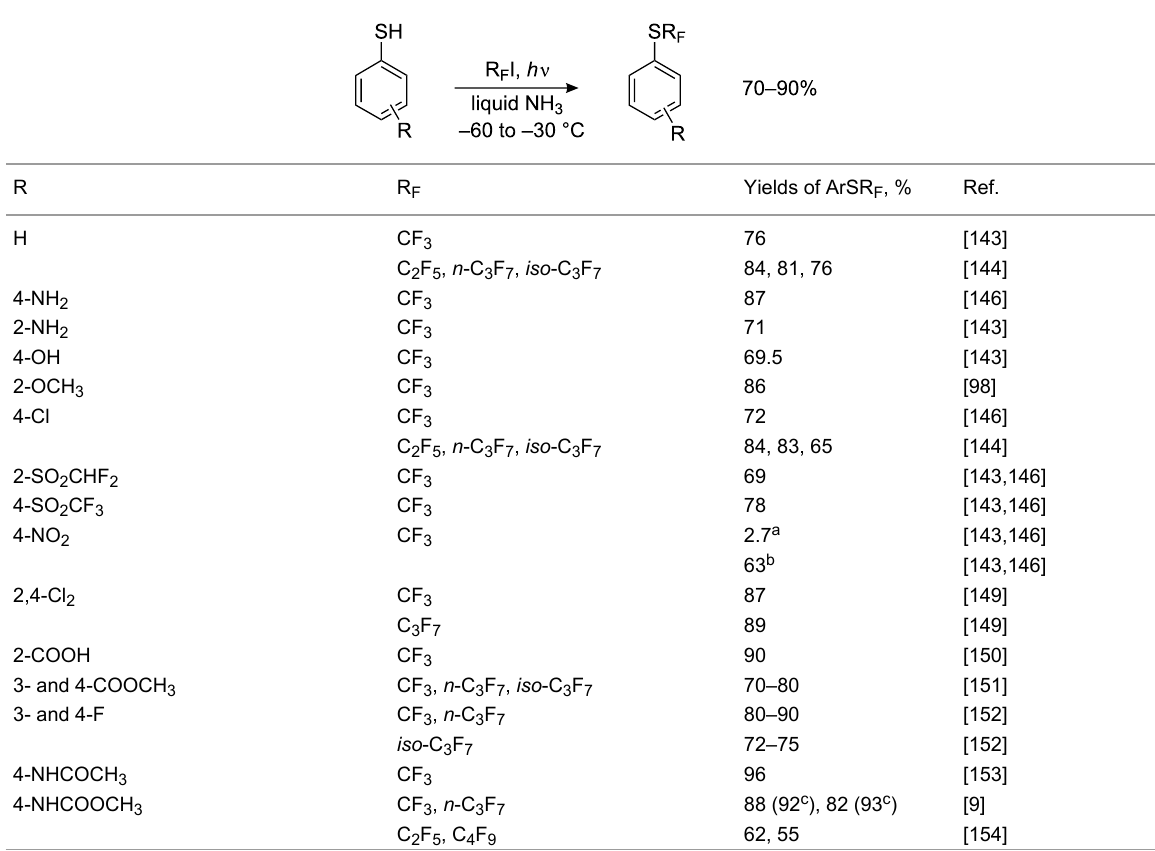
Table 1: Interaction of thiophenols with perfluoroalkyl iodides in liquid ammonia under UV irradiation.